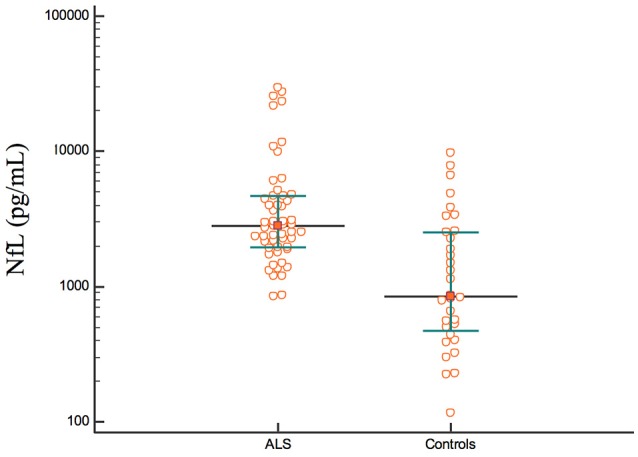
The concentrations of NfL in the ALS and control group.